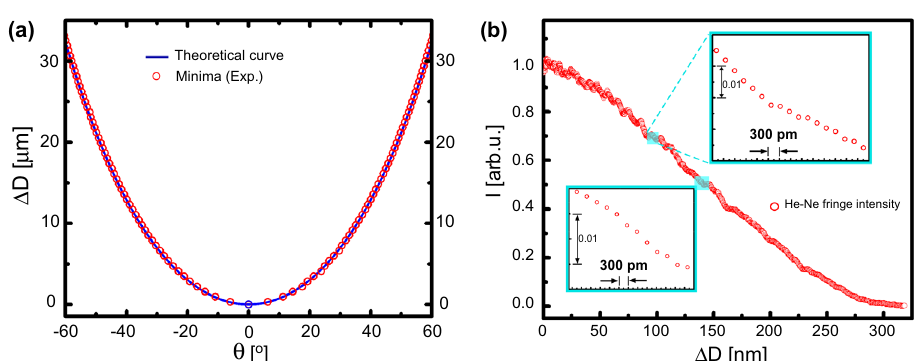
Figure 2. ( a ) Calibration of optical path delay (cid:31) D vs rotation angle θ for t = 140 μm and n = 1.516. Solid line is theoretical curve using Eq. (4) and experimental data corresponds to minima values of He–Ne laser interferogram. ( b ) Experimental data showing self-calibrated picoscale resolution from bright to dark fringe tuning. The intensity variation near zero position is attributed to the various noises in the